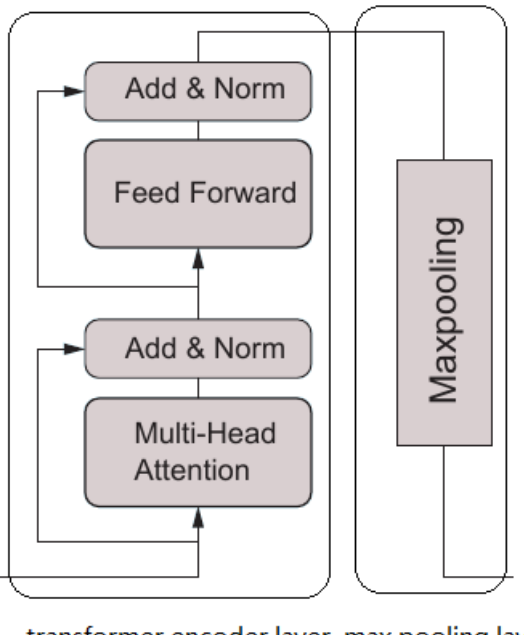
Figure 2. A Transformer block of the